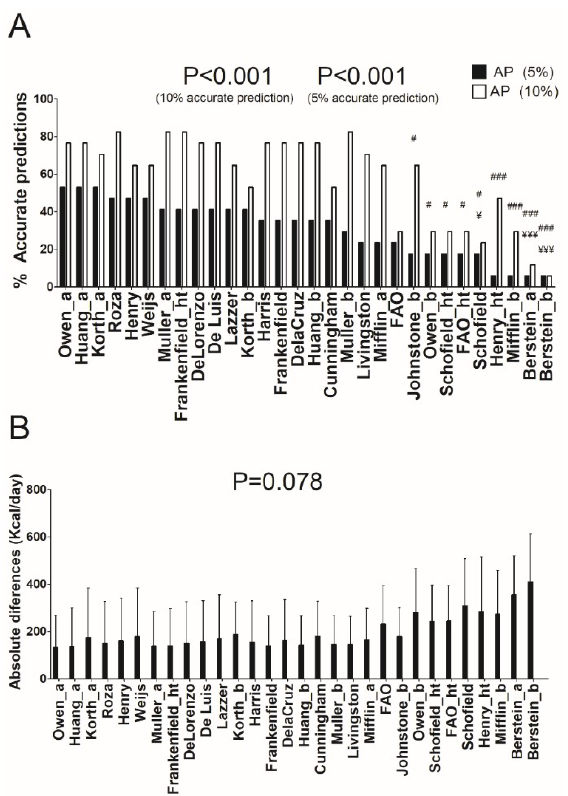
Figure 3. Percentage of accurate prediction of resting energy predictive equations and mean differences between predicted and measured resting energy expenditure in absolute values in individuals with obesity. ( A ) Percentage of prediction accuracy at 5% and 10% of resting energy expenditure. ( B ) Mean (SD) differences between predicted and measured resting energy expenditure in absolute values; p value of repeated measures analysis of variance (with Bonferroni post-hoc analysis) among the predictive equations; * = p < 0.05; ** = p < 0.01; *** = p < 0.001 when compared with the predictive equation that presented the least absolute differences with respect to the measured resting energy expenditure (Owen_a); ¥ = p < 0.05; ¥¥ = p < 0.01; ¥¥¥ = p < 0.001 when compared with the predictive equation that presented the best resting energy expenditure prediction accuracy (10%) with respect to the measured resting energy expenditure (Roza); # = p < 0.05; ## = p < 0.01; ### = p < 0.001 when compared with the predictive equation that presented the best resting energy expenditure prediction accuracy (5%) with respect to the measured resting energy expenditure (Owen_a). AP: Accurate prediction; “_a” refers to predictive equations which require only anthropometric parameters to calculate REE, “_b” refers to predictive equations which require body composition parameters to calculate REE, and “_ht” refers to predictive equations which are proposed by the same author and include height.